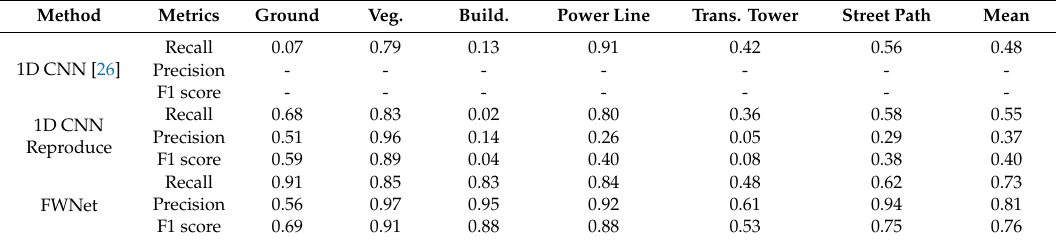
Table 2. Prediction results of the test data. Three metrics, recall, precision, and F1 score, were used. The bold text indicates the best performance. The 1D CNN ref is the result of reference [26], 1D CNN Reproduce is our experimental result using 1D CNN, and FWNet is our proposed method.